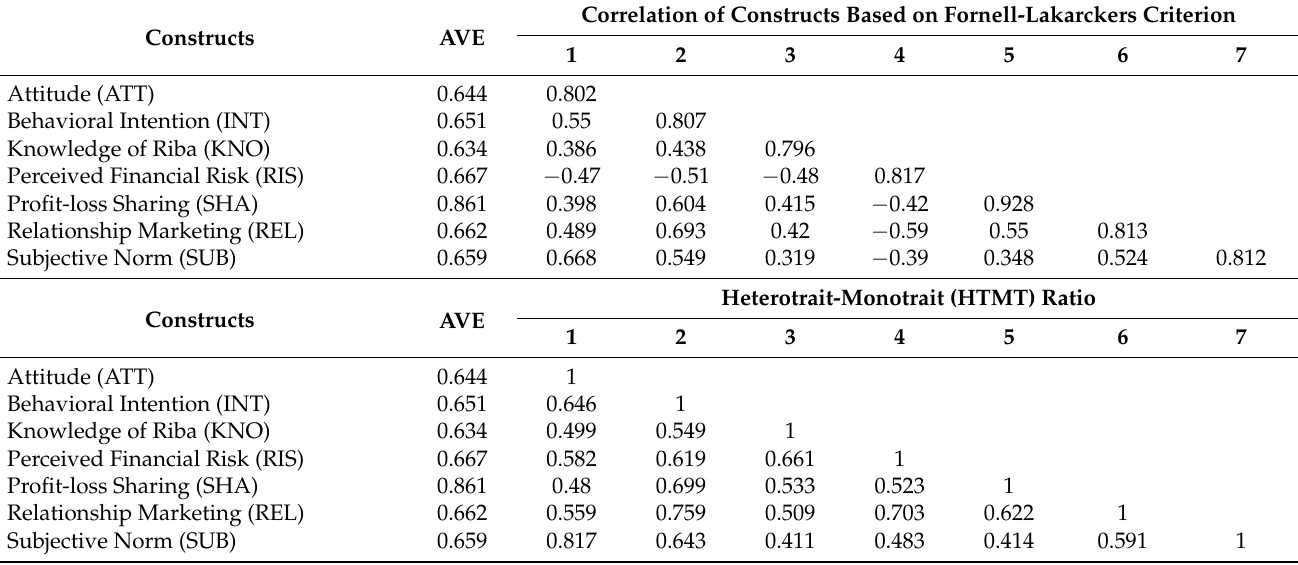
Table 3. Discriminant validity based on Fornell-Larckers and Heterotrait-Monotrait (HTMT)